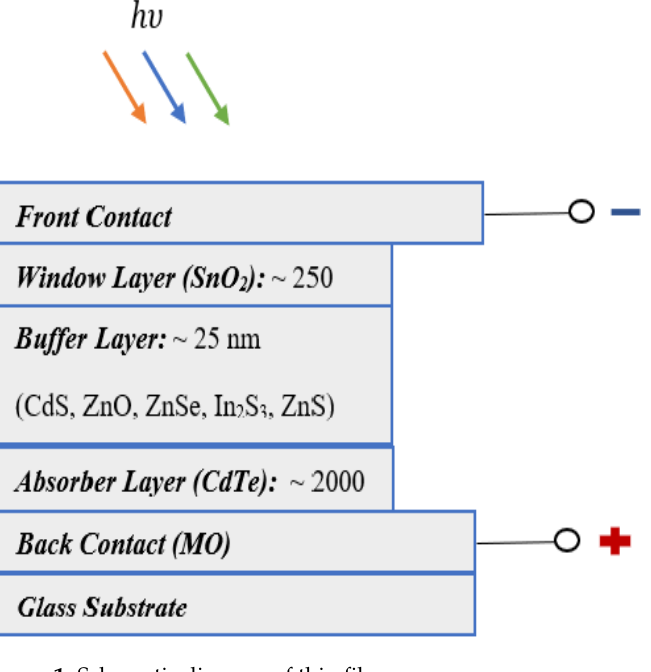
Figure 1. Schematic diagram of thin film.